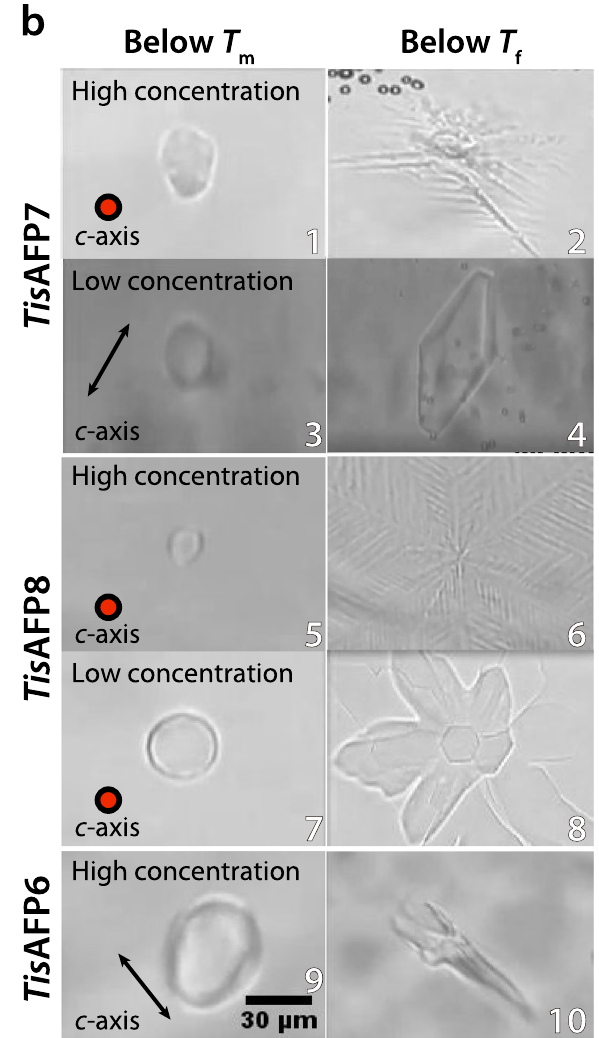
Figure 1. Comparison of the antifreeze properties of Tis AFP7 and two other Tis AFP isoforms, the moderately active Tis AFP6 and hyperactive Tis AFP8. ( a ) Plot of thermal hysteresis values for the three isoforms at various protein concentrations. Purple, Tis AFP7; red, Tis AFP8; and green, Tis AFP6. The values are means and the error bars are standard deviations from three independent observations at each protein concentration. The values for Tis AFP8 and Tis AFP6 are adopted from reference 22 . The curves were fitted for ease of interpretation. ( b ) Microscopic images of ice crystal morphology in solution of AFP isoforms at melting ( T m ) and non-equilibrium freezing temperature ( T f ). High and low concentrations denote 0.23 mM and 0.01 mM for Tis AFP7; and 0.12 mM and 0.01 mM for Tis AFP8. For Tis AFP6, ice crystals grown at 0.1 mM are shown. The c -axis direction of the ice crystal is shown in the figure as a circle or an arrow. The images are representative of three observations under each